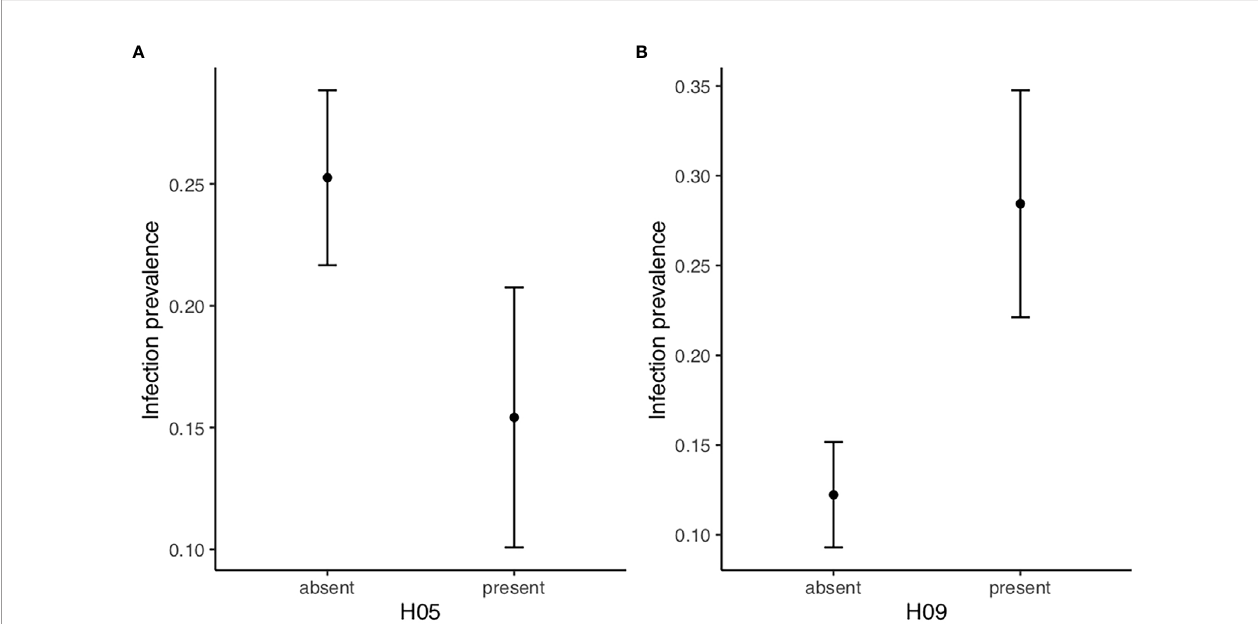
FIGURE 2 | Speci fi c MHC DQB-haplotypes are associatied with B. afzelii infection status. (A) Model estimates (LS means ± SE) of B. afzelii prevalence in bank voles (n=527) with haplotype H05 (n=77) is lower than for bank voles without H05. (B) Model estimates of B. afzelii prevalence in bank voles with haplotype H09 (n=44) is higher than for bank voles without H09. The model included age and month as class variables as well as H05 and